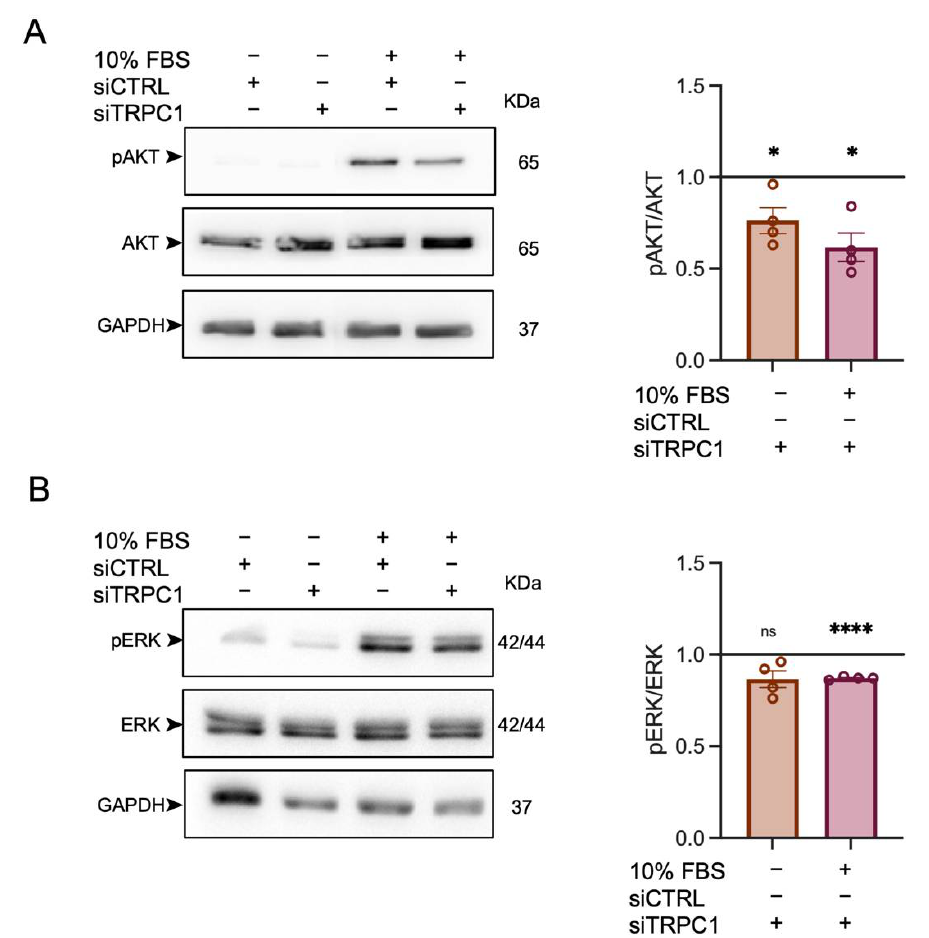
Figure 6. The knockdown of TRPC1 decreases PANC-1 cell proliferation through the phosphorylation of AKT pathways. ( A ) Western blot analysis of phosphorylated AKT (pAKT) and total AKT in transfected PANC-1 cells after mitogen-activation with FBS for either 0 or 30 min (left panel). Quantification of the western blot analysis compared to siCTRL either after 0 min or 30 min of mitogen activation (right panel). * indicates p < 0.05. ( B ) Western blot analysis of phosphorylated ERK1/2 (pERK1/2) and total ERK in transfected PANC-1 cells after mitogen-action for either 0 or 30 min (left panel). Quantification of the western blot analysis compared to siCTRL either after 0 min or 30 min of mitogen activation (right panel). Welch’s correction t -test was used to determine the significant difference between siCTRL and siTRPC1 conditions. ns indicate non-significant and **** p < 0.0001, respectively .